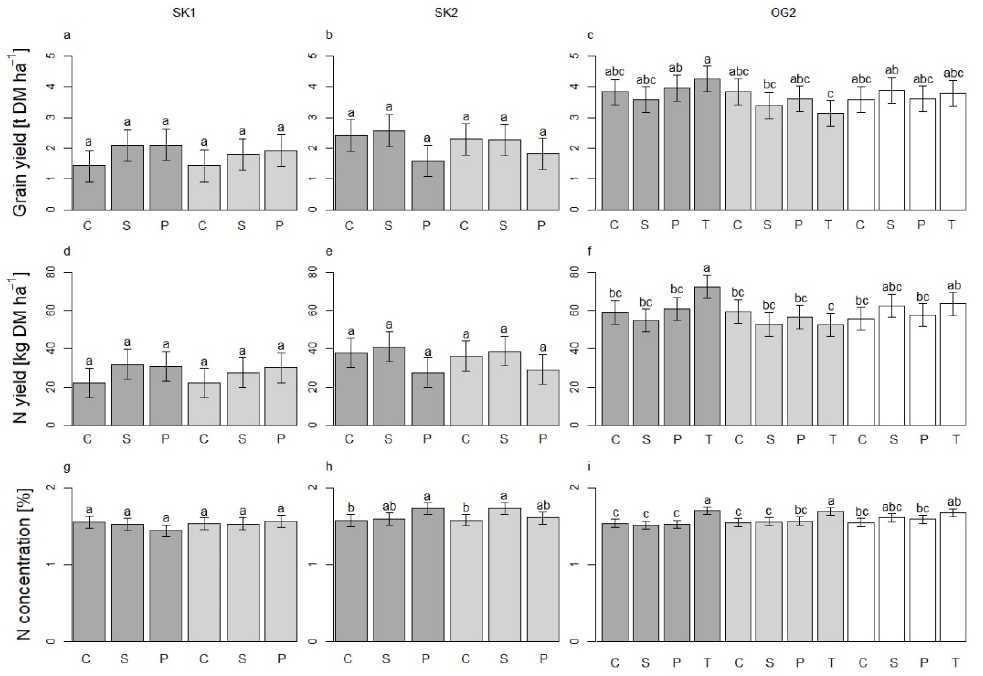
Figure 6. Dry matter (DM) grain yield ( a – c ), nitrogen yield ( d – f ), and nitrogen concentration in kernels ( g – i ) of winter wheat in the three experiments. Abbreviations: SK and OG stands for the two experimental regions, 1 = starting 2017, 2 = starting 2018, C = no service crop, S = frost-sensitive annuals, P = perennials, T = frost-tolerant annuals. No data are presented for winter wheat in the OG1 experiment since spring wheat was grown here this year. Colour coding indicating system strategy: dark grey = Early Intra, light grey = Late Inter, white = Late Adjacent. See Materials and Methods and Table 1 for information on treatments. Error bars indicate the 95% confidence interval, and the letters indicate significant differences between treatments within each experiment.